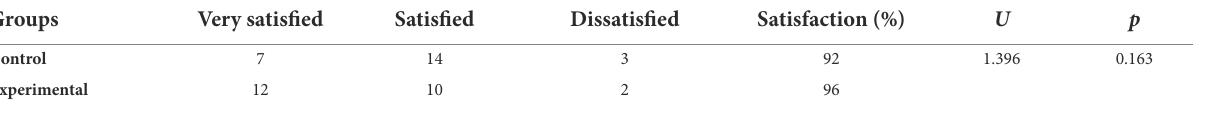
TABLE 4 Between-group comparison of patient satisfaction with nursing care(%).